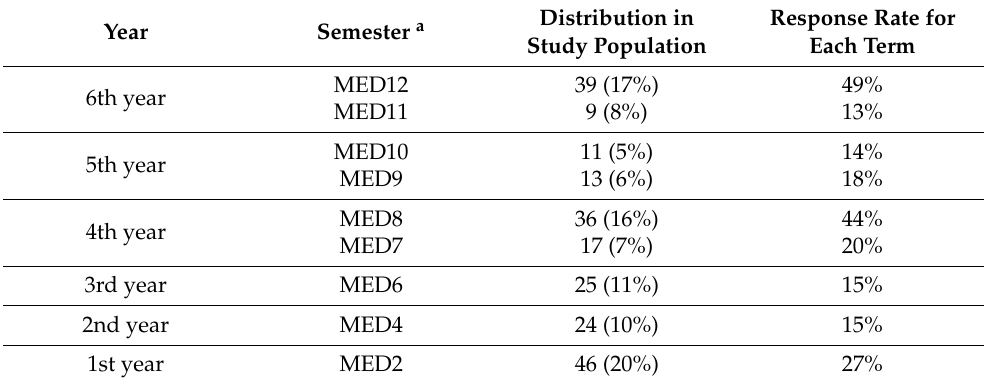
rate for the specific year and distribution of each year in the study population.